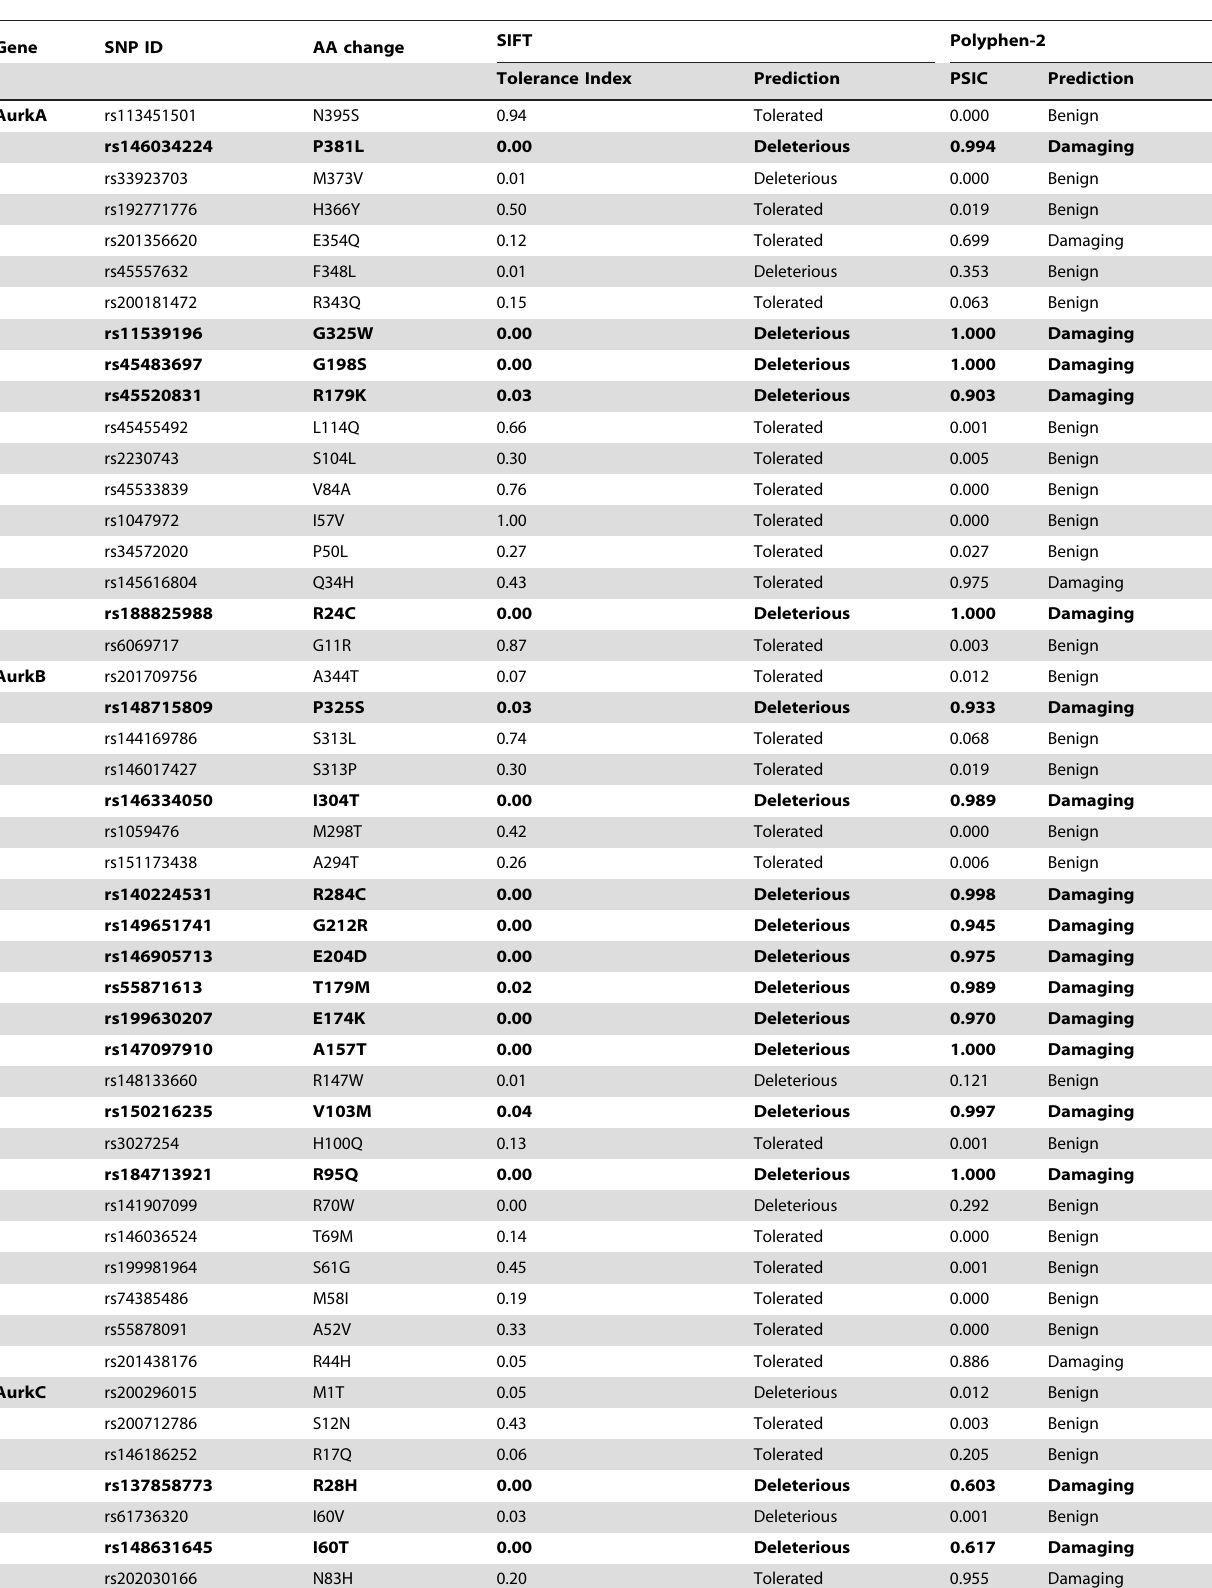
Table 1. Deleterious and damaging nsSNPs prioritized using SIFT tolerance score and Polyphen-2 PSIC score.